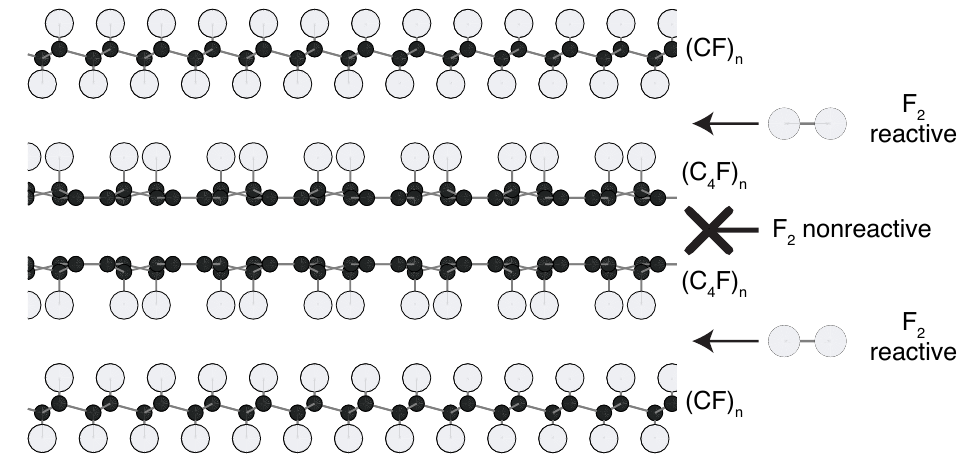
Figure 7. Proposed model of graphite fluoride structure under conditions where some graphite galleries resist fluorination. Black atoms, C; bluish-white atoms,